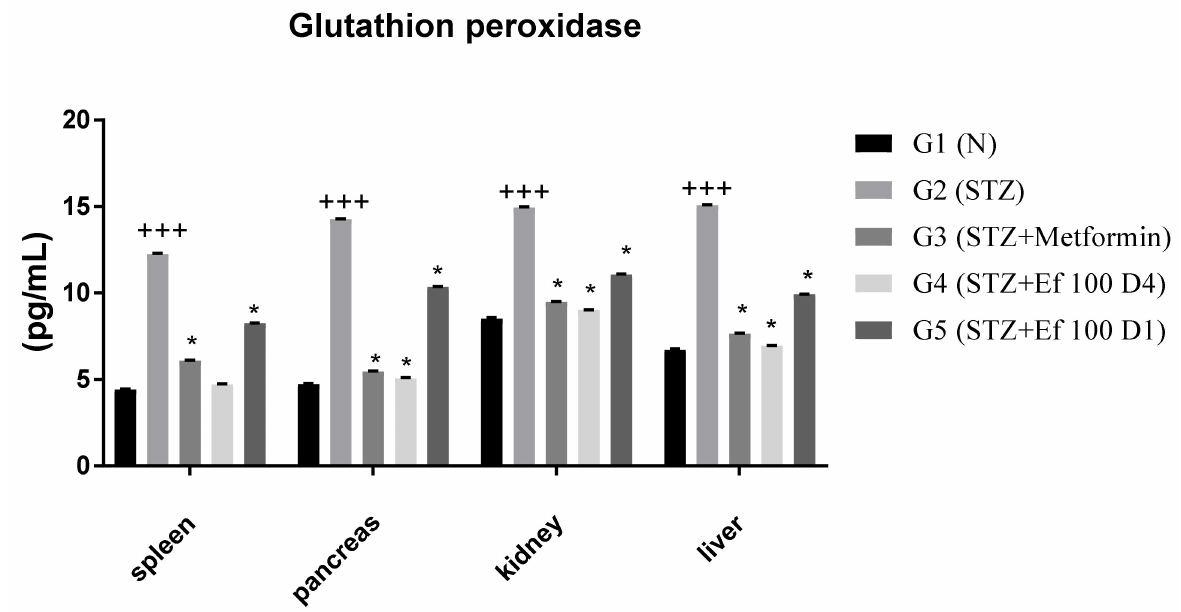
Figure 8. Concentrations of glutathione peroxidase in the spleen, pancreas, kidney, and liver of the experimental groups. Bars represent the mean of the glutathione peroxidase concentration ± SD of 6 rats. On Day 30, the animals were anesthetized and their organs, including liver, spleen, pancreas, and kidney, were collected and the concentrations of glutathione peroxidase in these organs were measured. The glutathione peroxidase concentrations were significantly ( p < 0.05) decreased in induced diabetic rats treated with metformin (G3) and Ephedra foeminea extract (G4 and G5) compared to the untreated induced diabetic rats’ group (G2). The results are expressed as means ± SD ( n = 3–4 dependent replicates). *: p < 0.05 compared to G2: diabetic rats. +++: p <